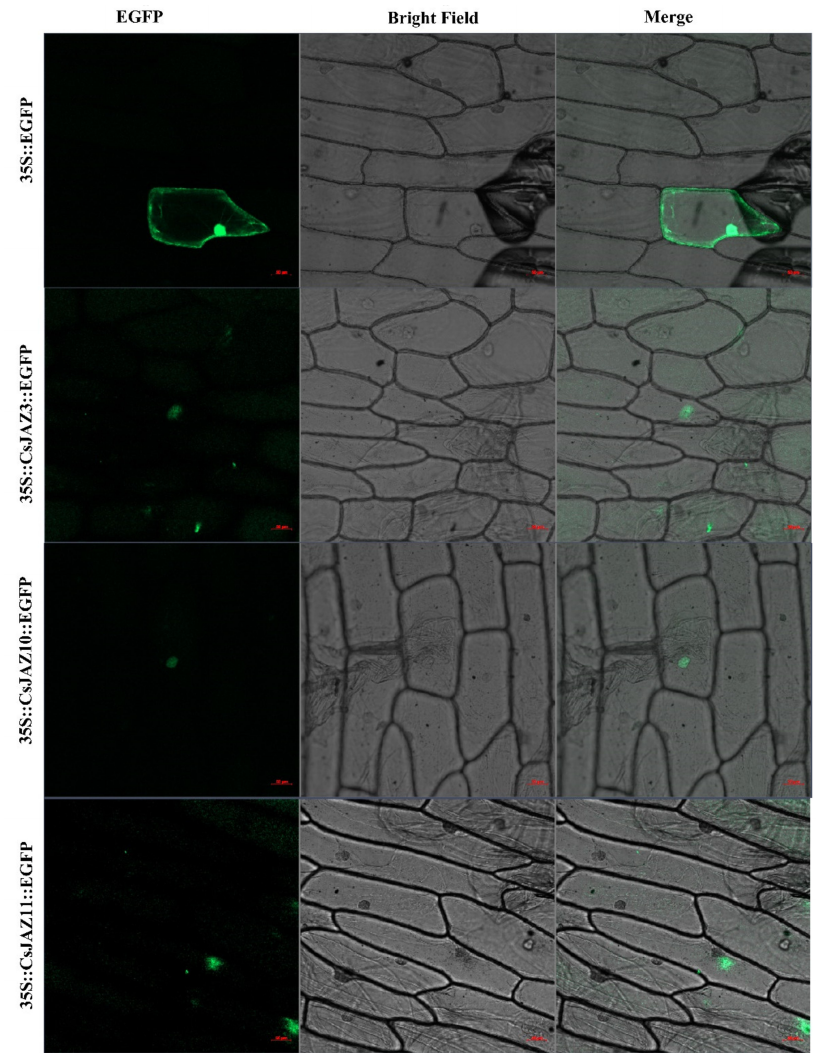
Figure 6. Subcellular localization of the fusion protein 35S::CsJAZ::EGFP in onion pidermal cells. The vector 35S::EGFP was used as the control. Bar = 50 µ m. The green indicated where the proteins were located. The red line indicated the bar was 50 µ